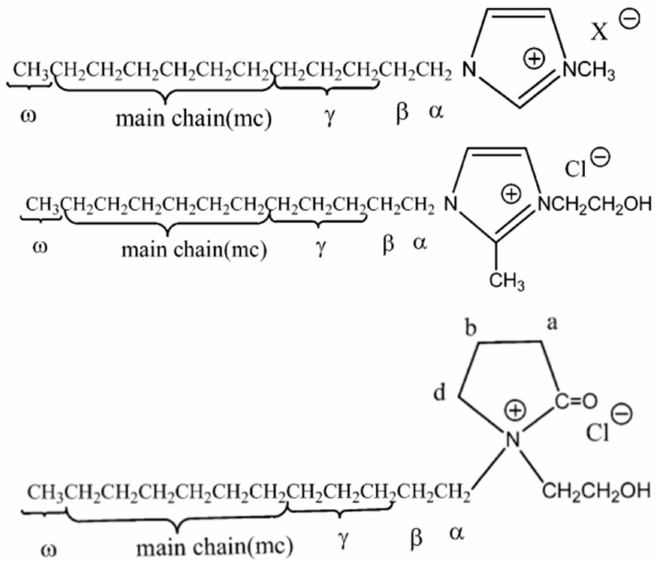
Figure 1. The structures of 1-alkyl-3-methylimidazolium, 1-alkyl-3-hydroxyethyl-2-methylimidazolium and N-dodecyl-N-hydroxyethylpyrrolidinonium ILs, respectively. Adapted from [18]. Pernak et al. [19] reported the antimicrobial potential of 1-[(1R,2S,5R)-( − )-menthoxymethyl]- 3-alkylimidazolium ILs. The salts demonstrated high antimicrobial activity, particularly